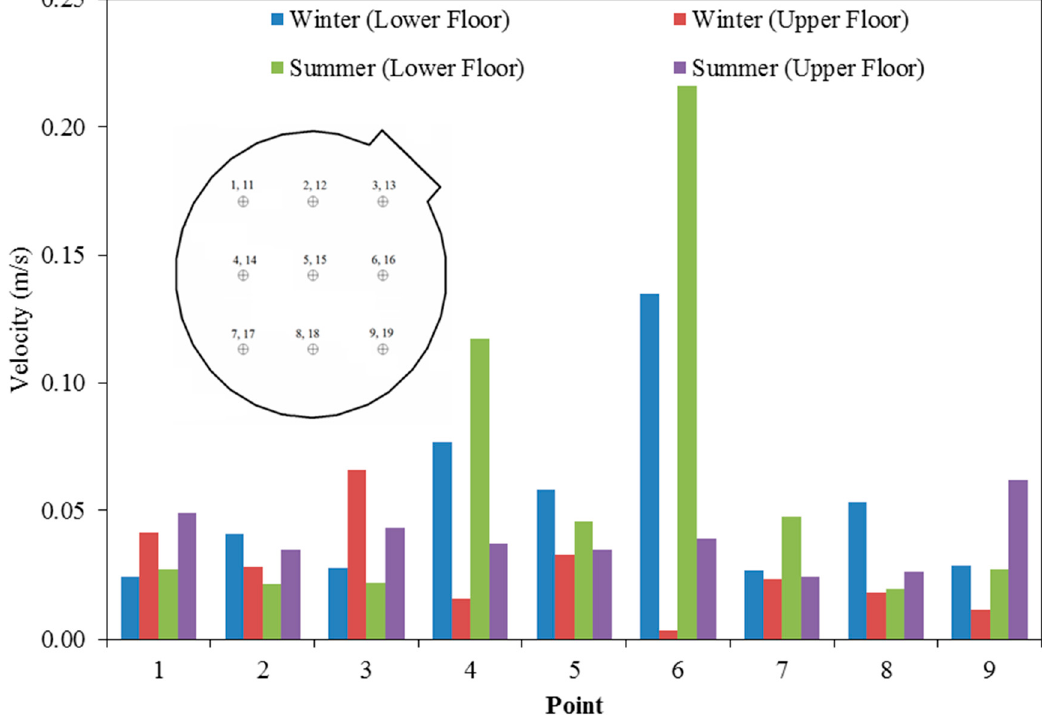
Figure 16. Comparison of the airflow speed distribution inside the dome house during winter and summer (buoyancy-induced flows).